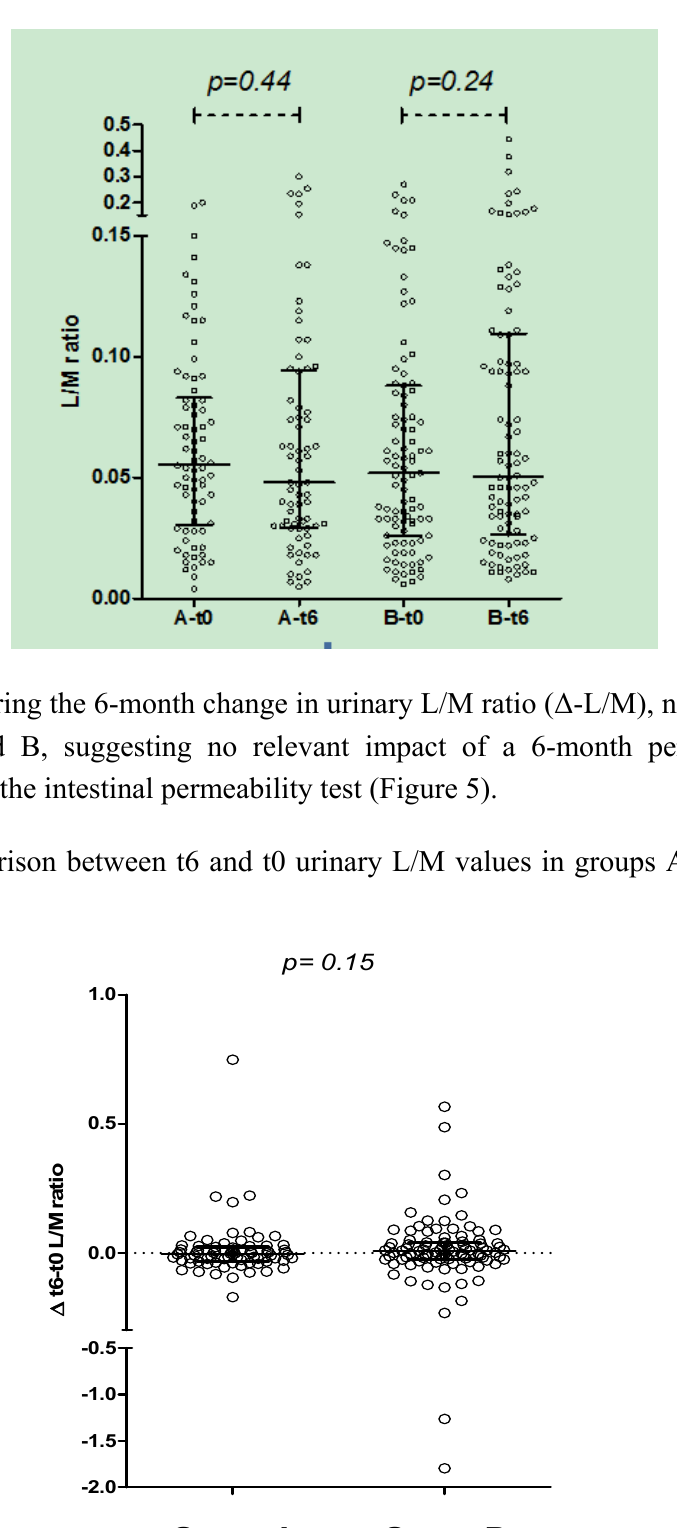
Figure 4. Urinary L/M ratio in group A and B at t0 and t6 (median, IQR): in both groups no significant difference was observed after 6 months of treatment.